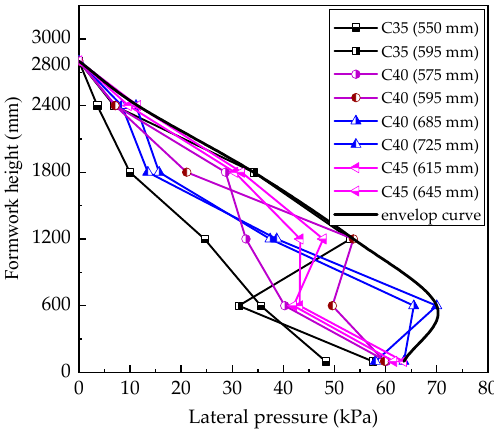
Figure 4. The change in maximum lateral pressure with the casting height of SCC.